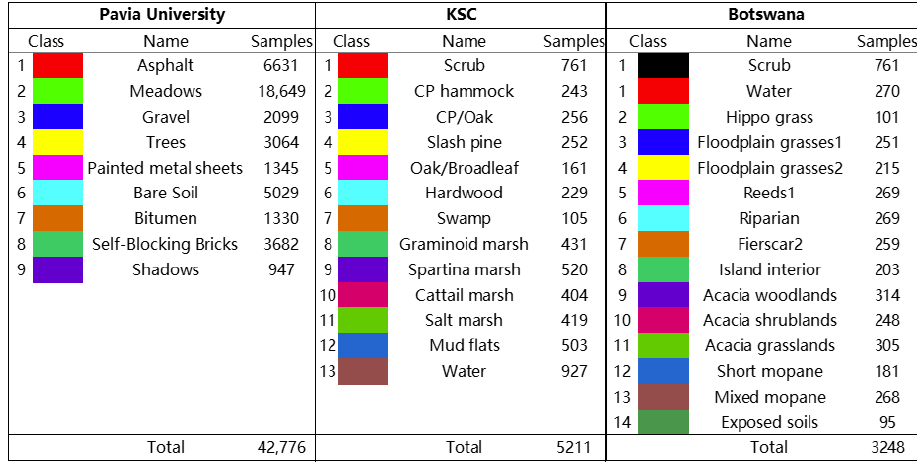
Figure 5. Details of Pavia University, KSC, and